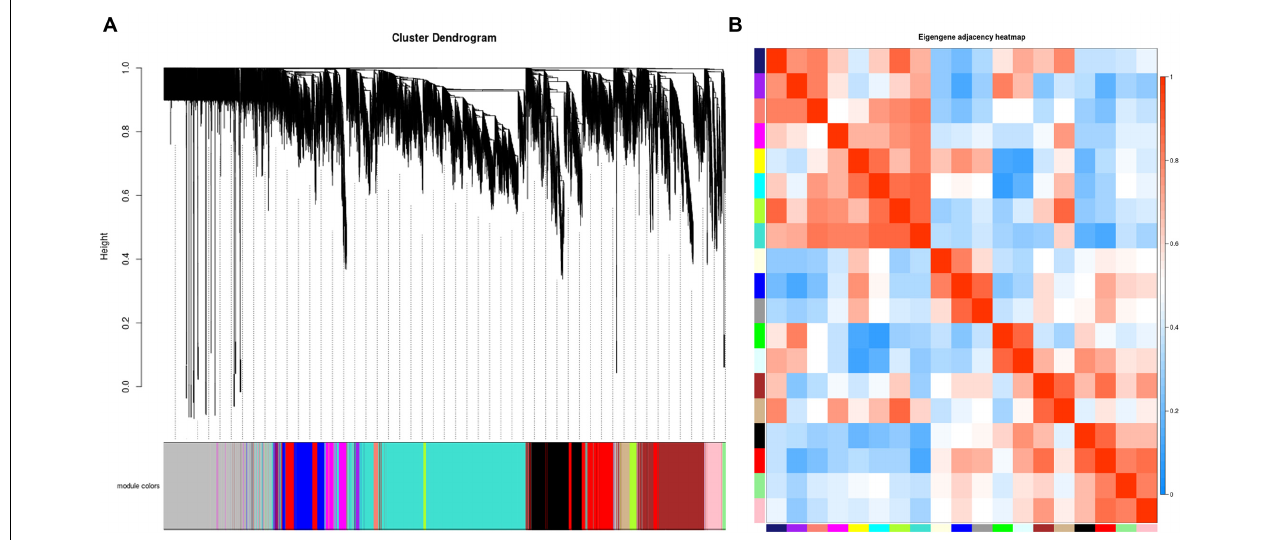
FIGURE 1 | Establishment of a co-expression network in whitefly. (A) Gene clustering tree (dendrogram) of 15,560 genes obtained via hierarchical clustering of topological overlapping dissimilarity. (B) Eigengene adjacency heatmap of the 19 modules in the network. Each row and column in the heatmap corresponds to one module (labeled in color). The scale bar on the right represents the correlation strength ranging from 0 (blue) to 1